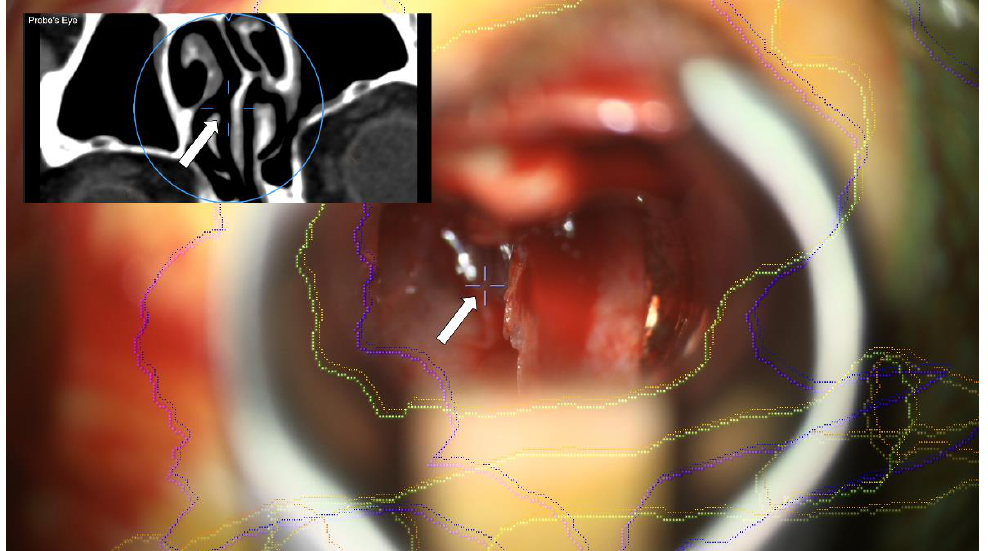
Figure 2. Usage of intraoperative landmarks, in this case, the septum, to evaluate navigational accuracy using the microscope and CT probe’s eye view (left upper corner), showing high navigation accuracy during surgery. Crosshairs (white arrows) showing the focus point in the microscope video and the corresponding CT probe’s eye view (left upper